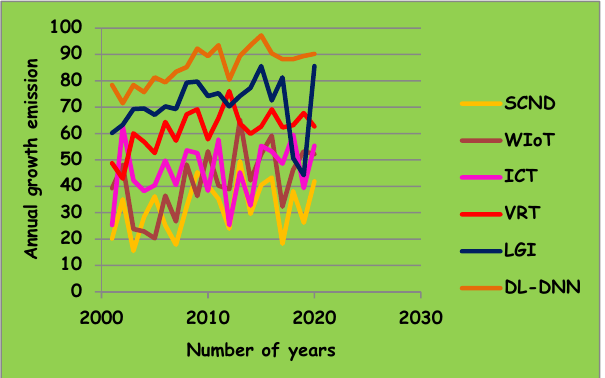
Figure 13: Characteristics of land use carbon